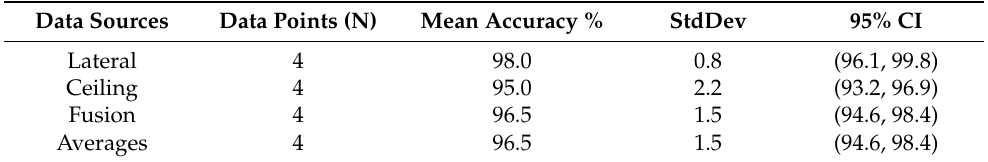
Table 6. Detailed analyses of Mean values from Lateral, Ceiling, and Fused datasets using one-way